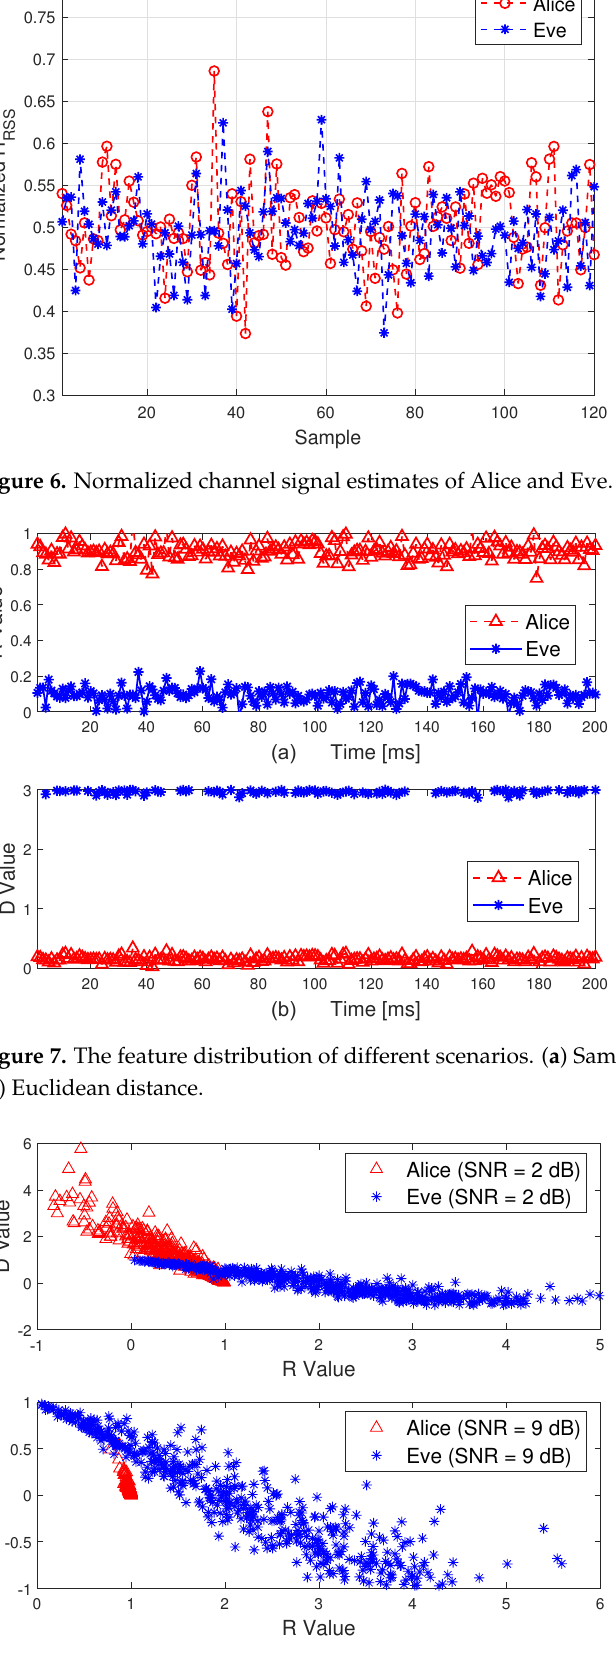
Figure 8. Characteristic distribution under different